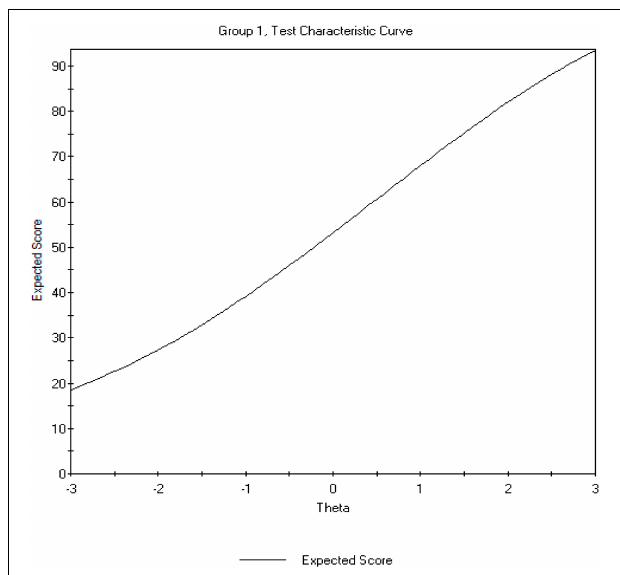
FIGURE 4 | Test characteristic